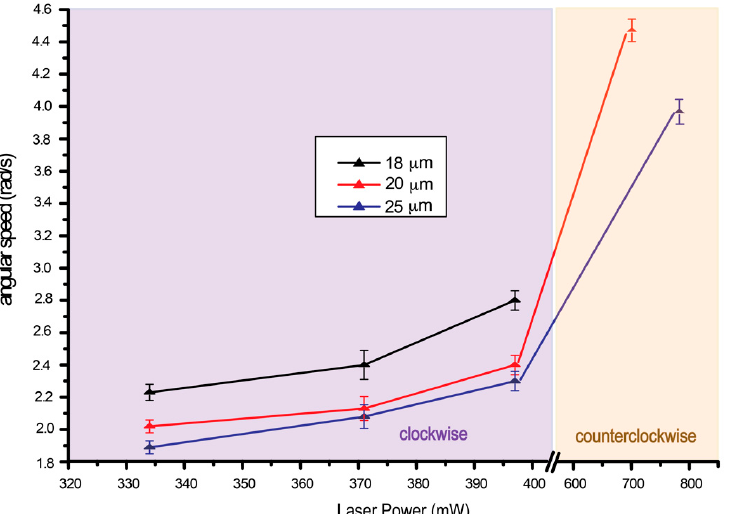
Figure 8. Plot of angular speed with laser power of a radial hedgehog defect under linearly polarized laser tweezers. Notice that we can only record one set of data for counterclockwise rotation for each droplet size since the power range for counterclockwise rotation is very small and by increasing the laser power higher than the last data plotted, the droplet was pushed out of the laser trap. For an 18 μ m droplet, no counterclockwise rotation was observed, analogous to the observation in Figure 7.